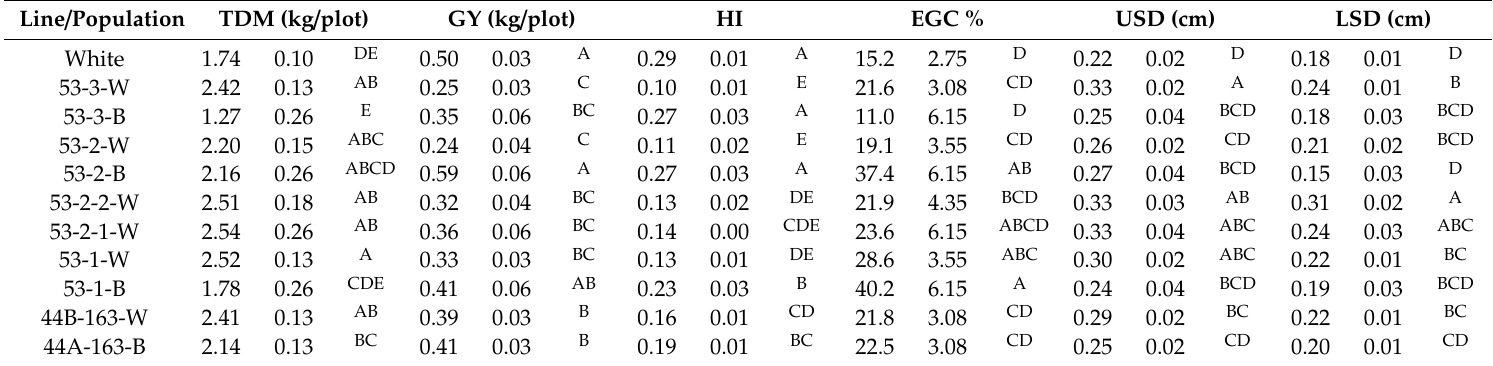
Di ff erent letters indicate significant di ff erences at p < 0.05. Table 4. LS means for Chla / gFW (Chlorophyll a), Chlb / gFW (Chlorophyll b), Chl / gFW (Total Chlorophyll), and Chl a / b ratio, for the studied population under field conditions.